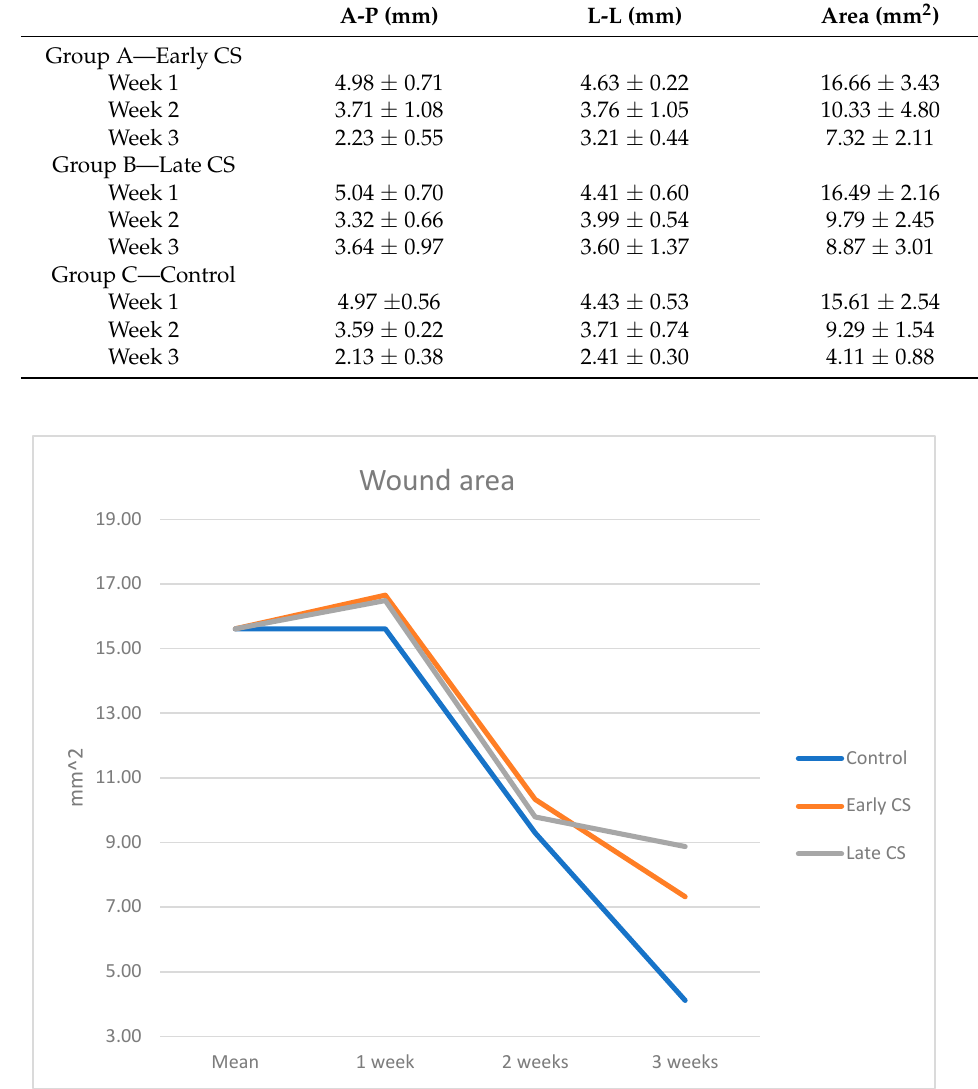
Table 1. Macroscopic wound area measurements (mean) as a factor of time in the distance (mm) and area (mm 2 ) indicators in the early corticosteroids group (test 1) vs. late corticosteroids group (test 2) and control.